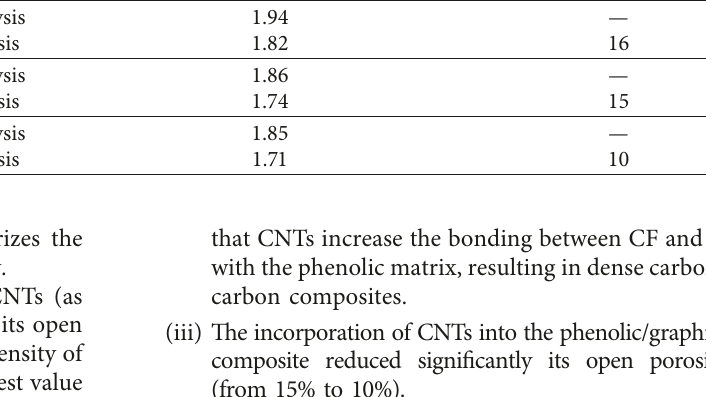
Table 2: Values of T m , T initial , and % weight remaining at 900 Composite samples